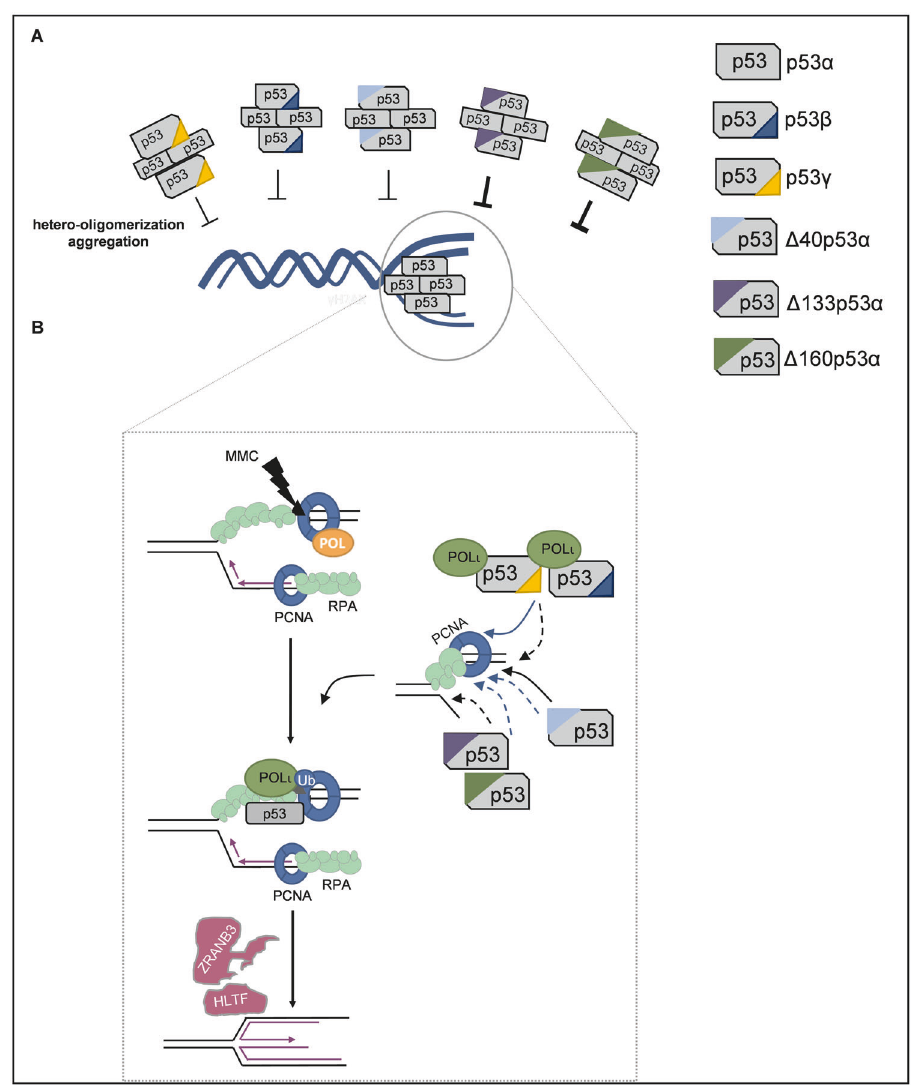
Fig. 8 Model for the impact of different p53 isoforms on POL ι -dependent DDT. A Hetero-oligomerization or aggregation of p53 α with alternative p53 isoforms, particularly with p53 α + Δ 133p53 α or p53 α + Δ 160p53 α , can antagonize p53 α functions in the POL ι -dependent DDT. B C-terminal p53 isoforms still interact with PCNA [20, 41] but are compromised in binding to three-stranded DNA junctions like replication forks due to shortened OD [38]. Intact DBD, OD, and RPA-interaction sites [8], but compromised interactions with POL ι and PCNA due to lack of the N-terminal end in Δ 40p53 α permit limited replication fork recognition only. Δ 133p53 α or Δ 160p53 α are compromised in DNA-binding due to the N-terminally truncated DBD and in RPA-, POL ι and PCNA-binding due to the missing N-terminus. However, all N-terminal p53 isoforms retain the OD, enabling hetero-oligomerization with p53 α and therefore dominant-negative interference with p53 α functions in performing idling events in complex with POL ι and PCNA, giving time for PCNA ubiquitination and FR events by HLTF and ZRANB3 [19]. Black arrows, DNA-binding; blue arrows, PCNA-binding; stippled arrow, compromised